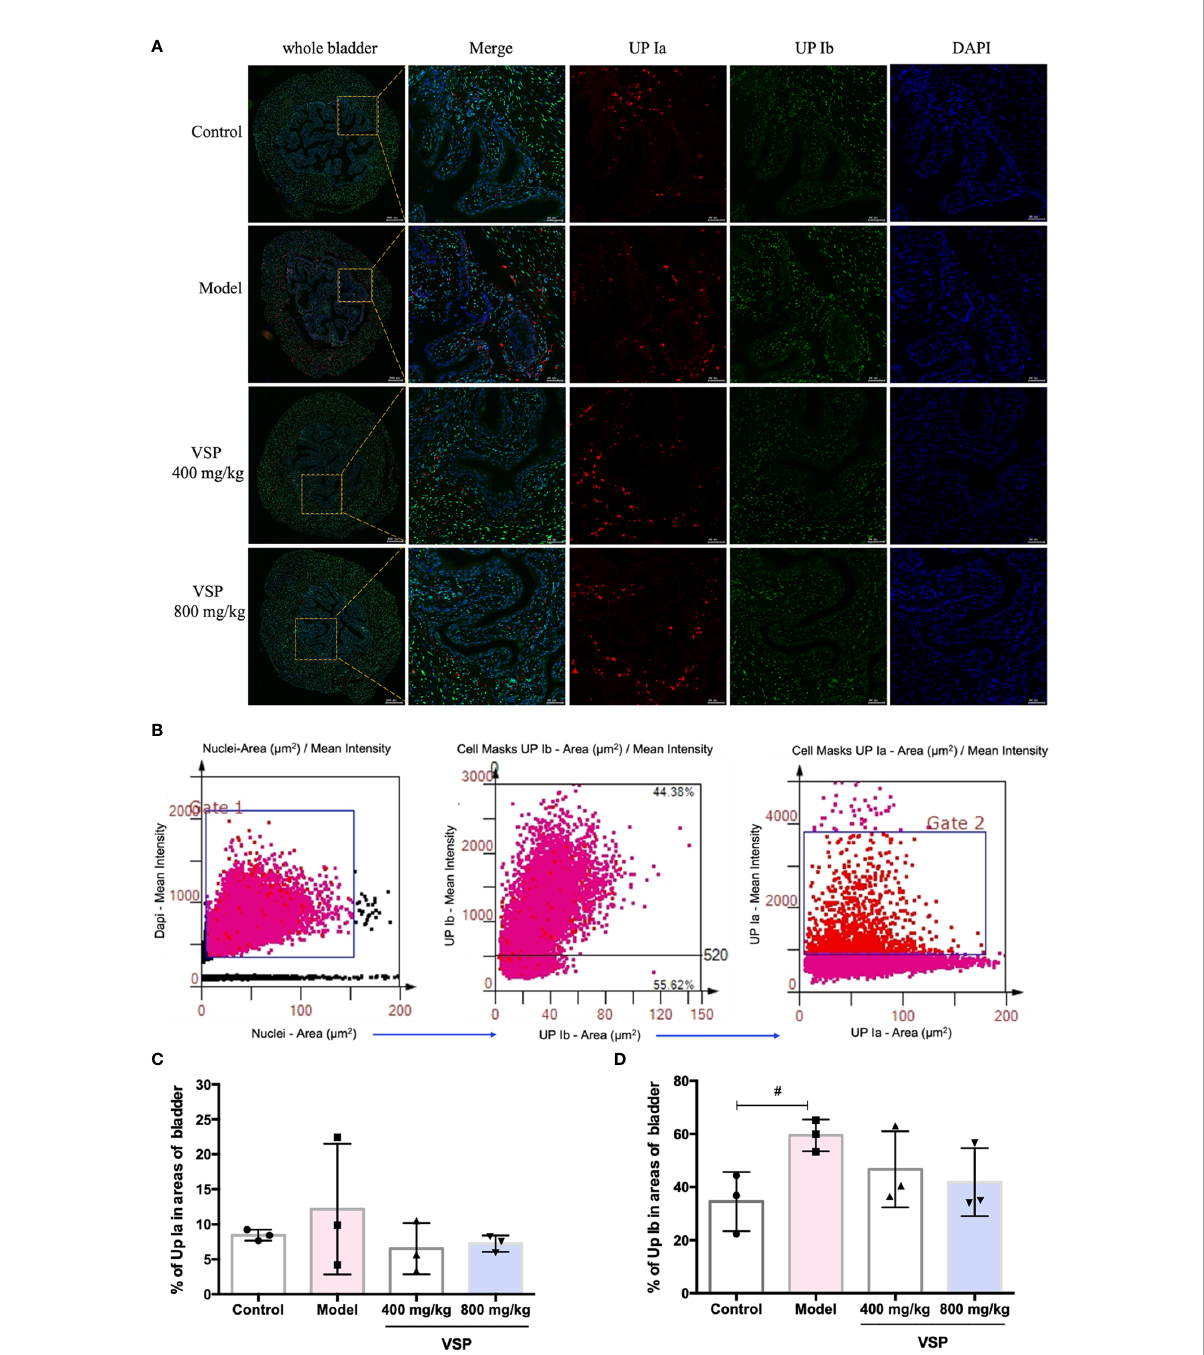
FIGURE 7 VSP inhibited the levels of UP Ia and UP Ib in the mouse bladder. (A) , Representative costained images with UP Ia, UP Ib, and DAPI captured the bladder tissue of the UPEC CFT073-infected C3H/HeN mice. Yellow rectangle: higher magni fi cation view of the selected area (parallel sections, the green signals represent UP Ia, the red signals represent UP Ib, the blue signals represent DAPI, scale bar = 50 m m); (B) , Representative scatterplots for the UPIa and UPIb expression levels from the bladder tissue of the C3H/HeN mice infected with UPEC CFT073. (C, D) , Statistical analysis of the UPIa- and UPIb-positive cells in the entire cross-sectional tissue region of the mouse bladder. Quantitatively, the percentage of cells expressing UPIa (UPIa/DAPI) and UPIb (UPIb/DAPI). n =3 mice per group, compared with the control group: # p < 0.05. The results were determined by Wilcoxon rank-sum